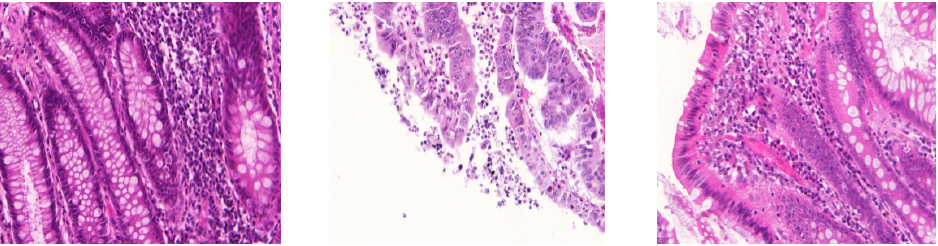
Figure 1. Stain variations in H&E-stained histopathology images. Images are taken from colon cancer dataset [5].